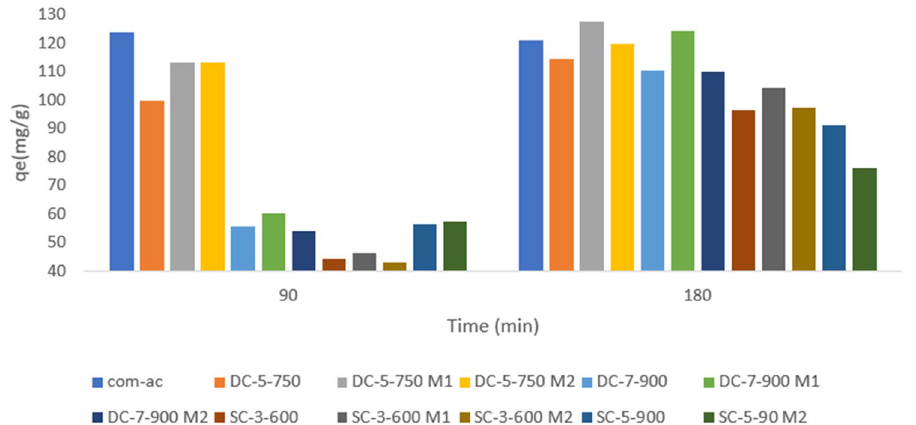
Figure 15. preliminary adsorption capacity results for MR.